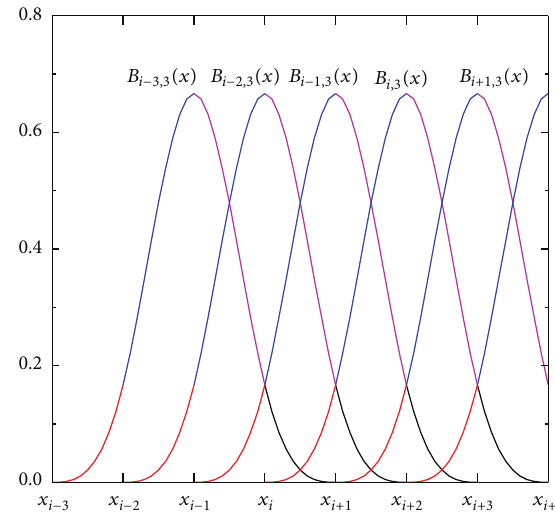
Figure 2: Cubic B-spline curve in piecewise form.